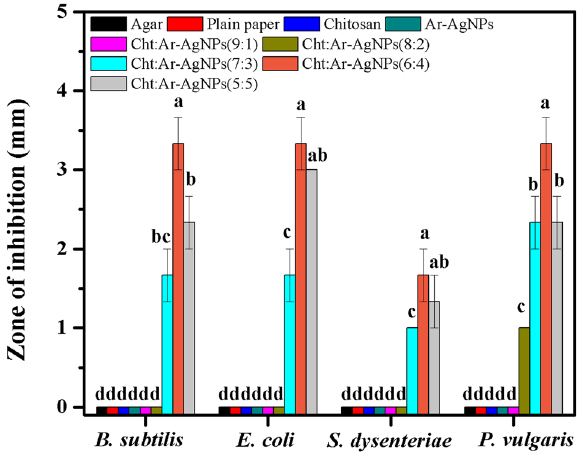
Figure 8: E ff ect of antibacterial activity of plain paper, chitosan, agar, Ar - AgNPs - coated paper, and coated papers with di ff erent ratios of chitosan and Ar -